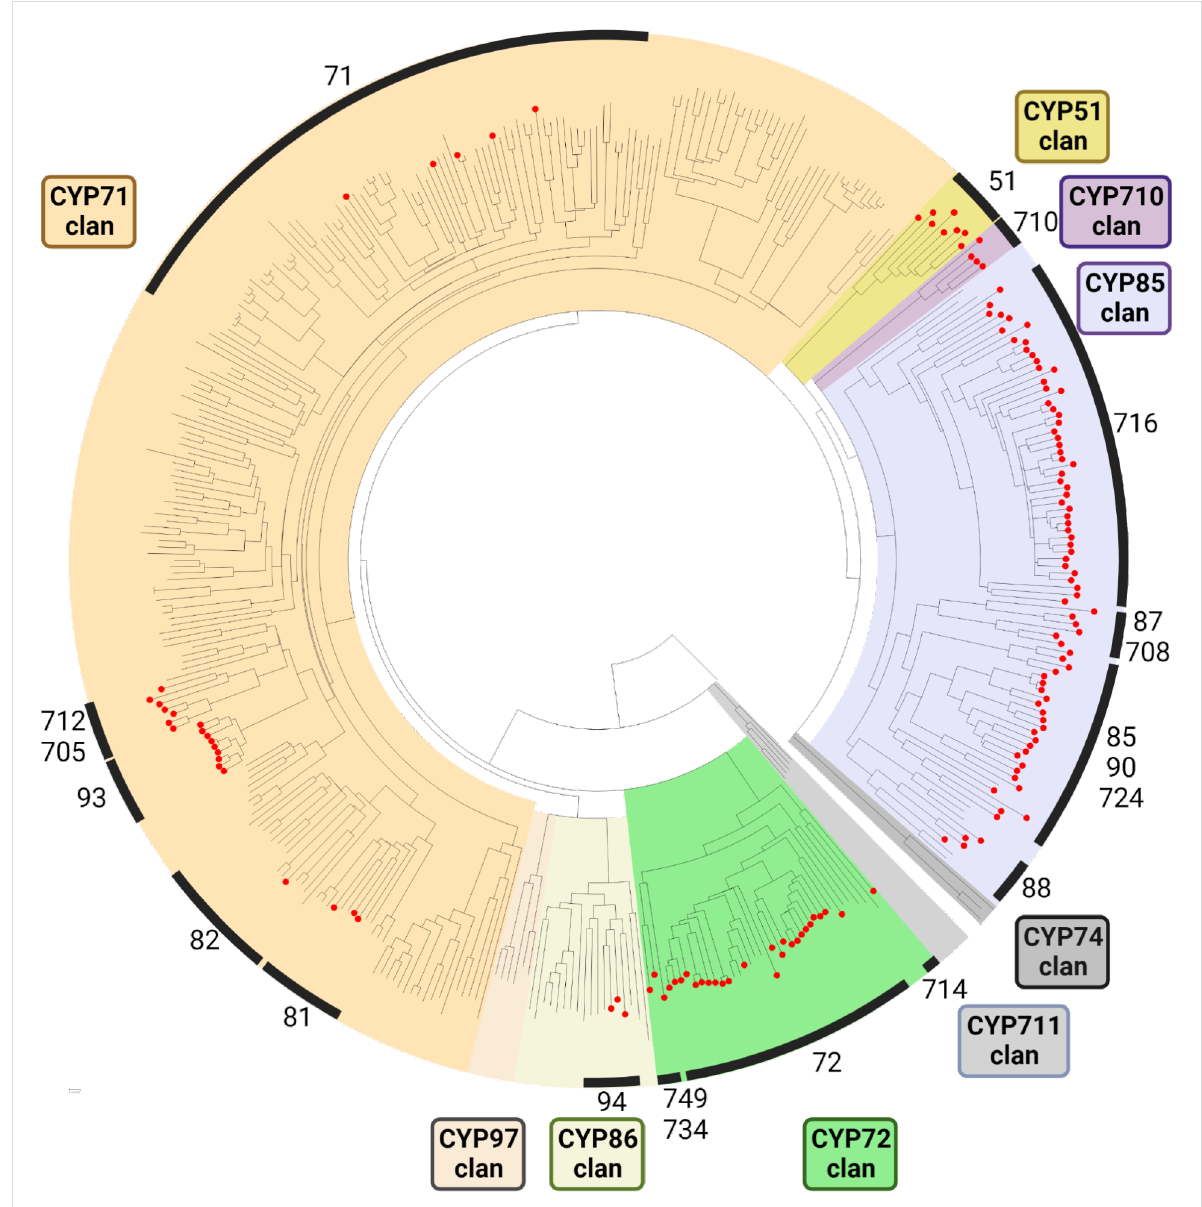
Figure 2: Phylogenetic distribution of CYPs acting on triterpenoid and steroid scaffolds (red nodes) compared to other CYPs from higher plants [15]. Numbers and black bars mark CYP families containing CYPs known to act on triterpenoids and steroids. Amino acid sequences (149 triterpenoid CYPs, 266 non-triterpenoid CYPs) were aligned using MUSCLE [92], and a neighbour-joining consensus tree of 1,000 bootstrap replicates was gener- ated using the Jukes–Cantor model. The final tree was visualised in Python using the ete3 package. Annotations in Figure 2 were created with BioRender.com. This content is not subject to CC BY 4.0. A high resolution version with tip labels is available as Supporting Information File 1.